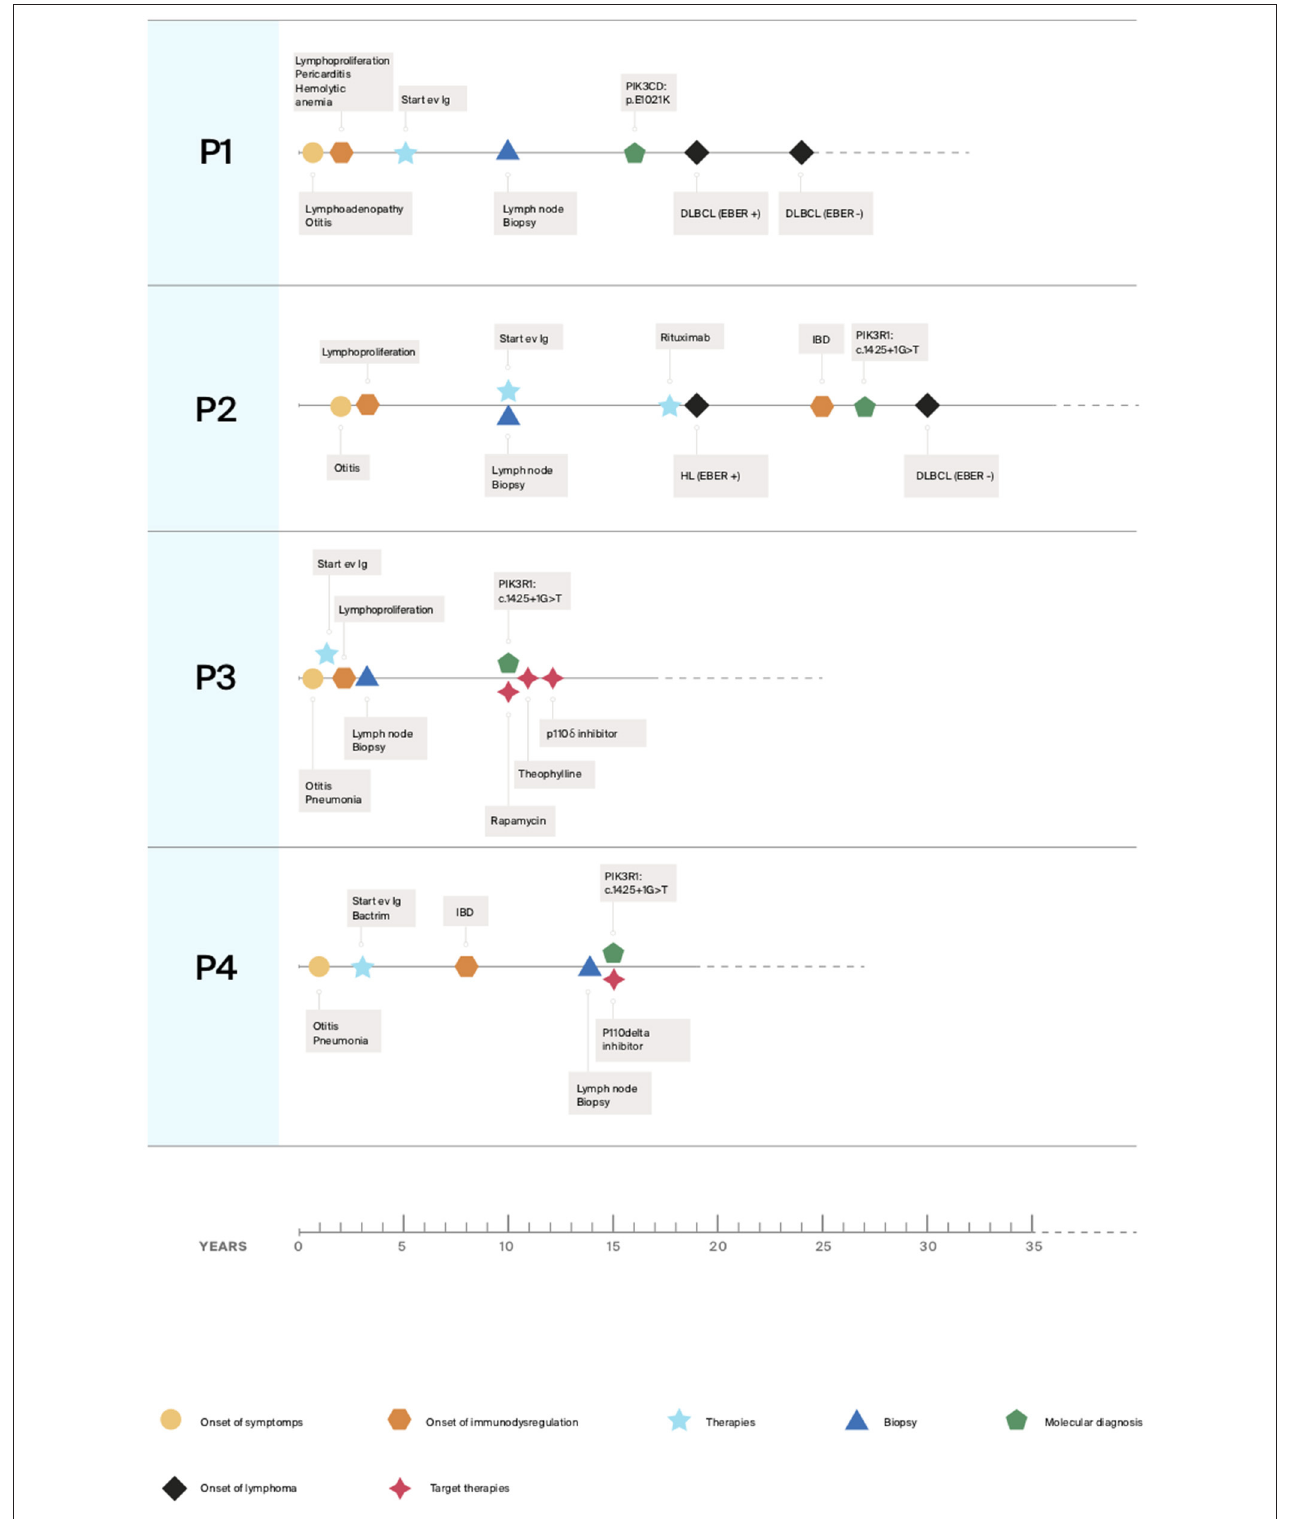
FIGURE 1 | Clinical histories